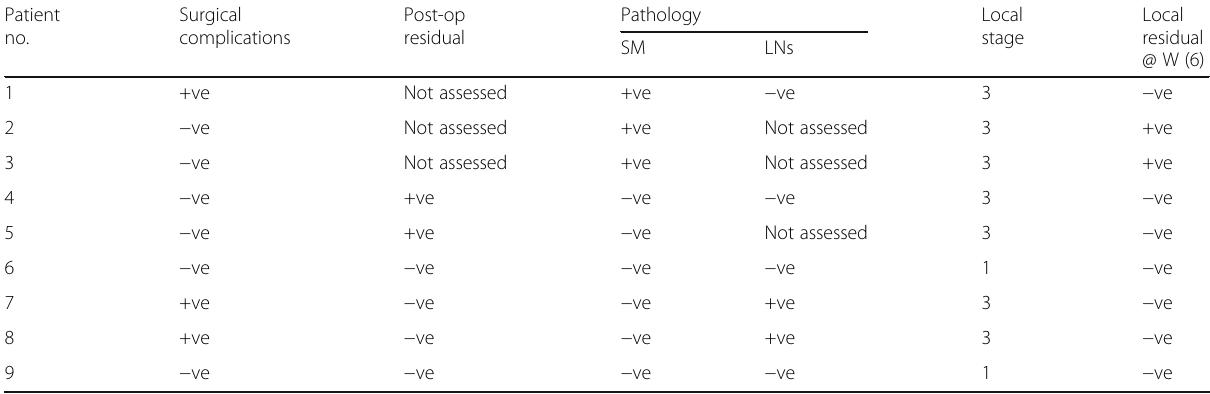
Table 2 Surgical and pathological outcome of patients with up-front nephrectomy ( n = 9) Patient